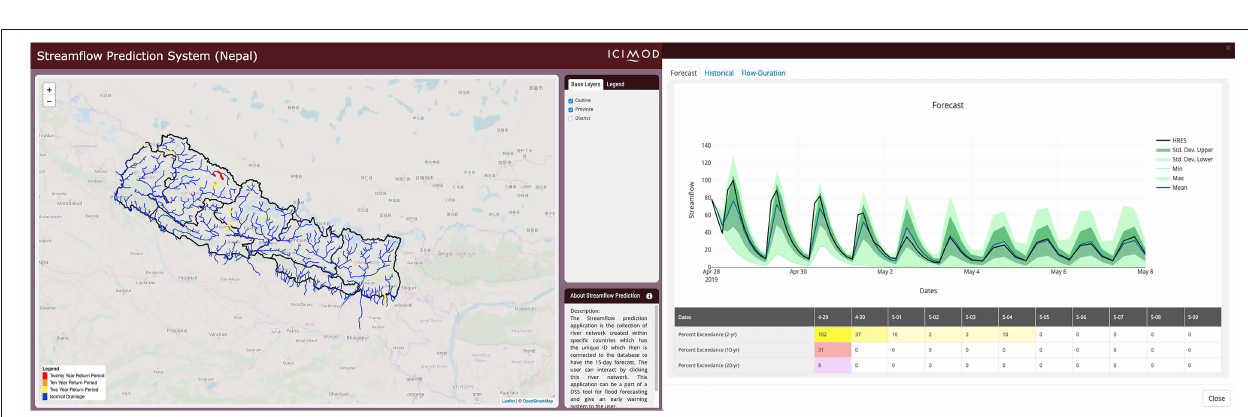
FIGURE 7 | Nepal streamflow prediction system derived from the global streamflow prediction